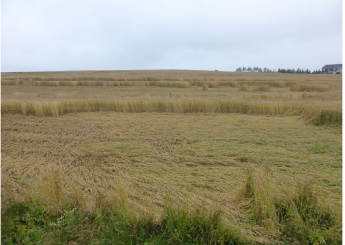
Figure 3. Sample ground image of a barley field with lodging damage from Flight2